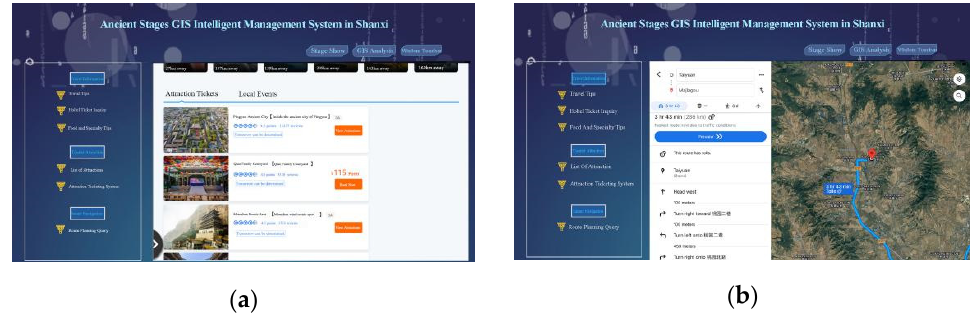
Figure 15. Intelligent tourism. ( a ) Introduction of sites. ( b ) Optimal route planning.